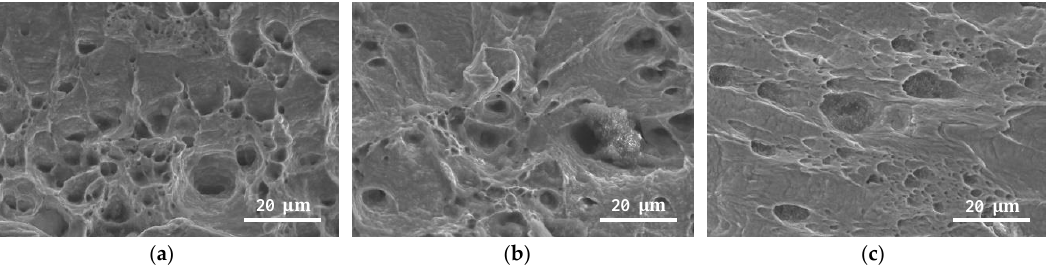
Figure 9. SEM of the fracture surface of copper obtained from ( a ) DNTT ( b ) staggered DNTT with 𝛼 = 80° and ( c ) shear test specimens.